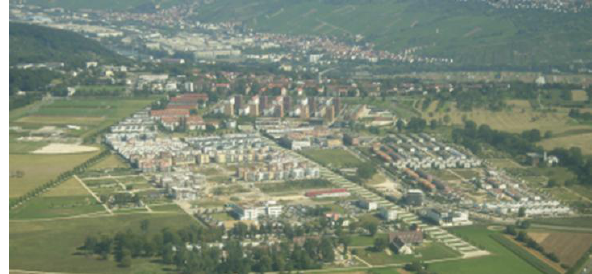
Figure 3. Residential area Scharnhauser Park (Eicker et al, 2010)